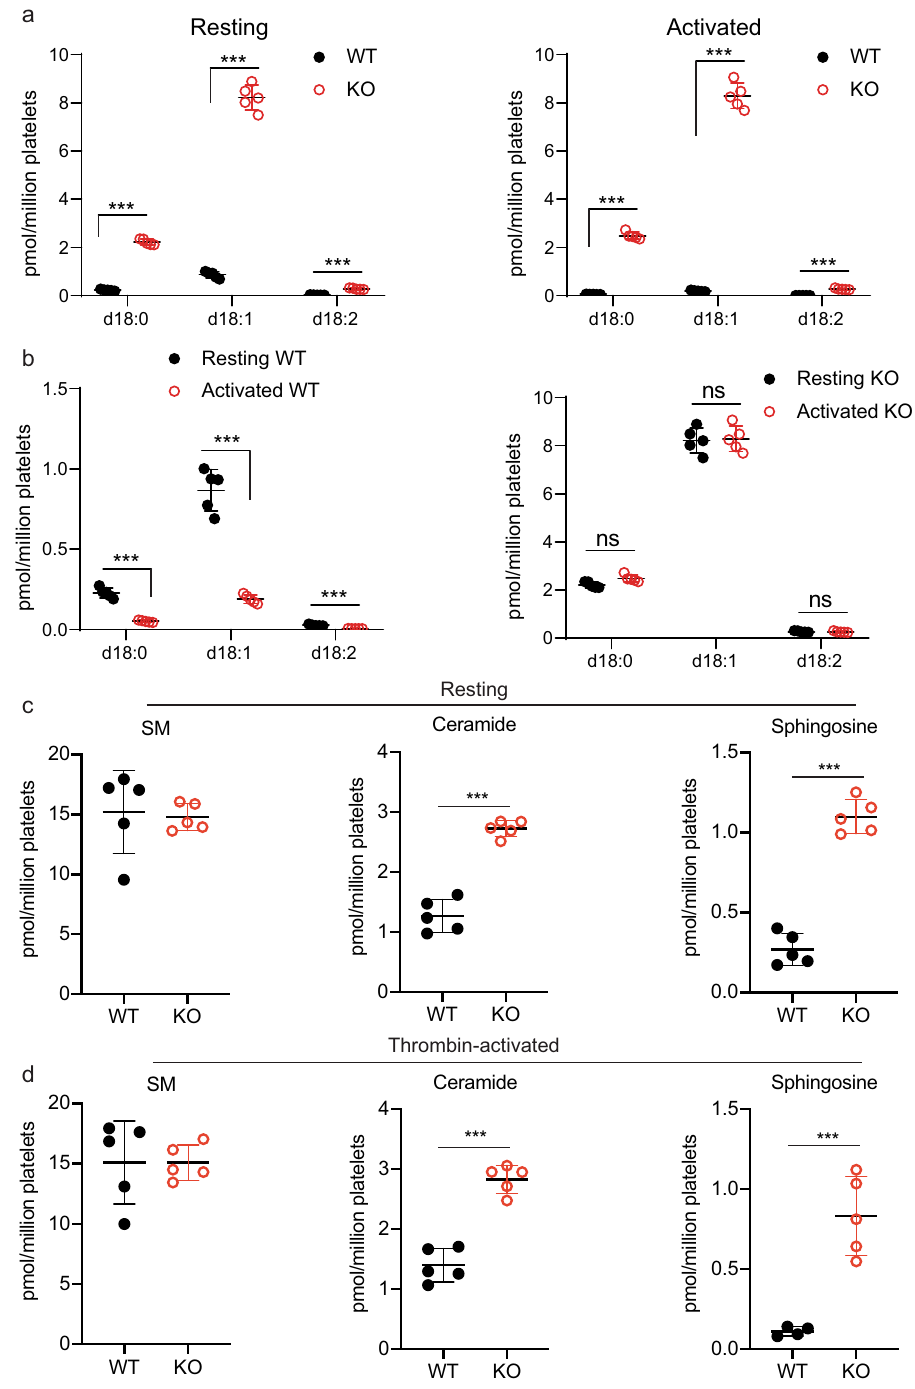
Fig. 3 Mfsd2b is likely a promiscuous S1P transporter. a Levels of individual S1P species from resting and thrombin-activated WT and Mfsd2b KO platelets. These are major S1P species found in platelets. Data are mean and SD. Each dot represents one mouse ( n = 5). *** P < 0.001. One-way ANOVA was used. b comparison of the levels of each S1P species measured from resting and thrombin-activated WT and KO platelets, respectively. There was a reduction in S1P levels in WT platelets at activated conditions (right panel). Thrombin-activation did not reduce S1P levels in Mfsd2b KO platelets (left panel). Data are mean and SD. Each dot represents on mouse ( n = 5). *** P < 0.001; ns not signi fi cant. One-way ANOVA was used. WT wild type, KO knockout. c , d Levels of sphingomyelins (SM), ceramides, and sphingosines found in WT and Mfsd2b KO platelets before and after thrombin activation, respectively. Levels are the sum of all measured molecular species in each lipid class. The levels of ceramides and sphingosines were slightly elevated in KO platelets. However, note that the degree of S1P accumulation is much greater compared with ceramides and sphingosines. Data are mean and SD. Each dot represents one mouse ( n = 5). *** P < 0.001, two-tailed unpaired t -test was used. Individual lipid species can be found in the supplementary data 1. SM